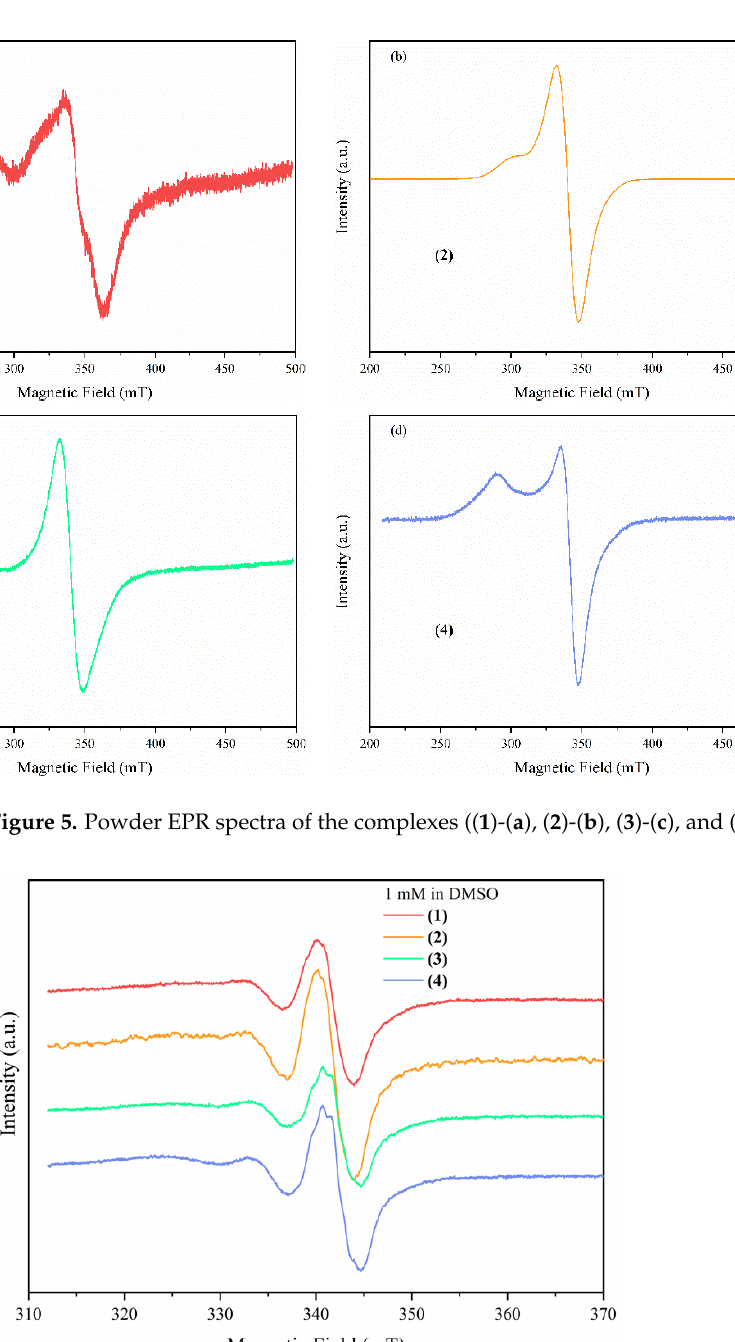
Figure 6. The EPR spectra of the Cu(II)-based complexes in a 1 mM DMSO solution after one week.